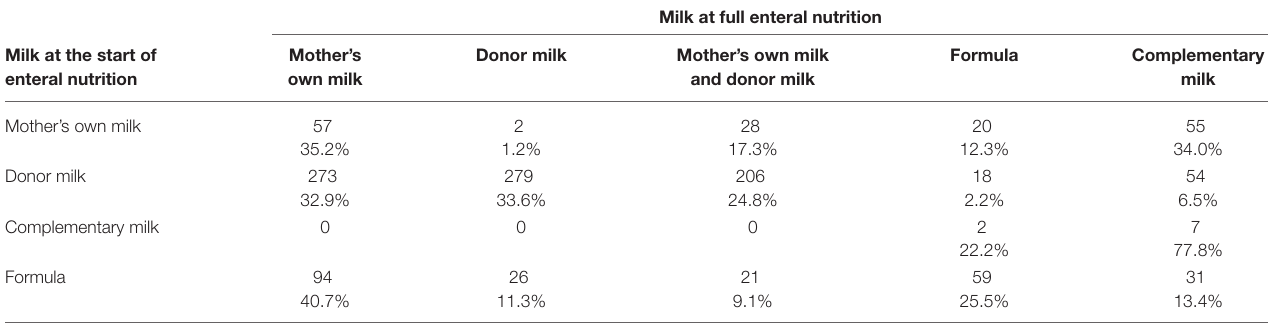
TABLE 3 | Type of milk at full enteral feeding stratified by type of milk at start of enteral nutrition.